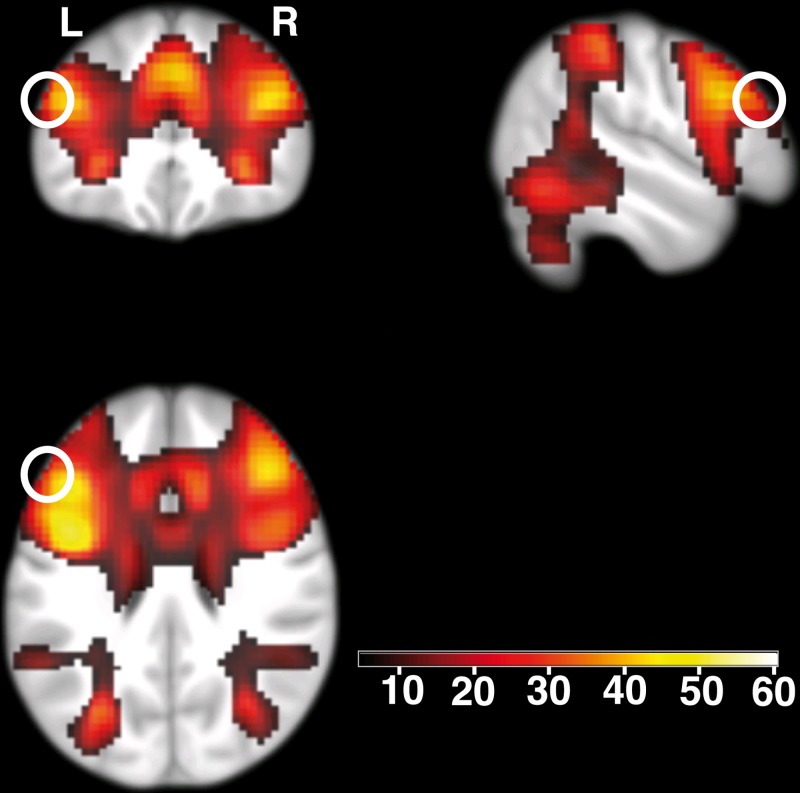
Brain activity related to working memory.Prefrontal activity, color-coded t values (p
whole-brain-FWE-corrected
< 0.05; N = 707). The white circles depict the area within the left dorsolateral prefrontal cortex stimulated by TMS (centered at [–53, 31, 25] in Montreal Neurological Institute space). Activations are overlaid on coronal (top left), sagittal (top right), and axial (bottom left) sections of a study-specific group template. L, left side of the brain; R, right side of the brain.